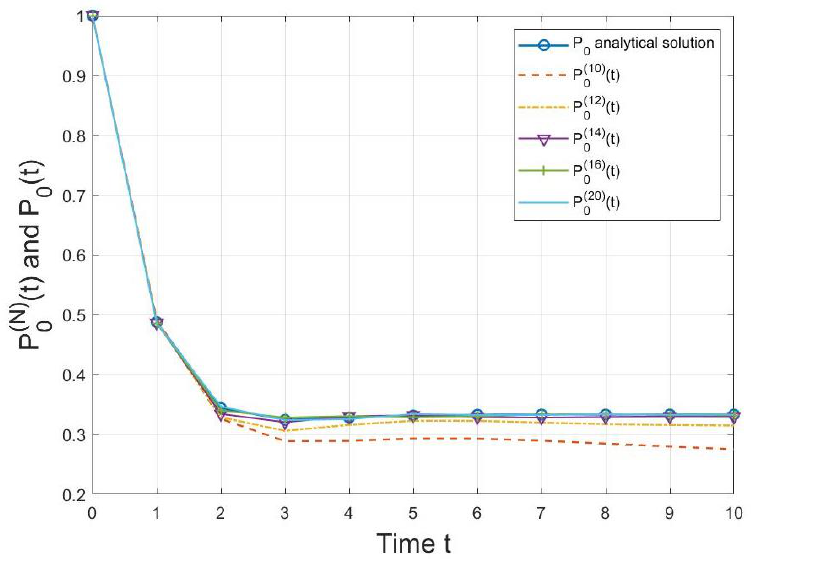
( N ) ( t ) derived by (30) and the analytical solution P 0